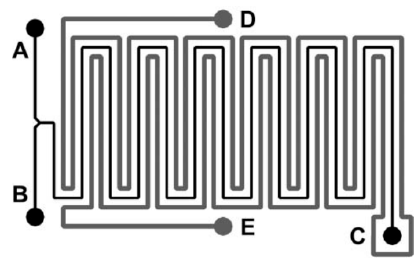
Figure 11. Arrangement of two microchannels from Iles et al. [82]: the reaction channel A/B-C and a collateral microchannel D-E filled with encapsulated TLCs for temperature mapping of the Reimer-Tiemann reaction in a meandering microchannel. Reprinted by permission from Ref. [82], Lab on a Chip, Copyright © 2022 The Royal Society of Chemistry.